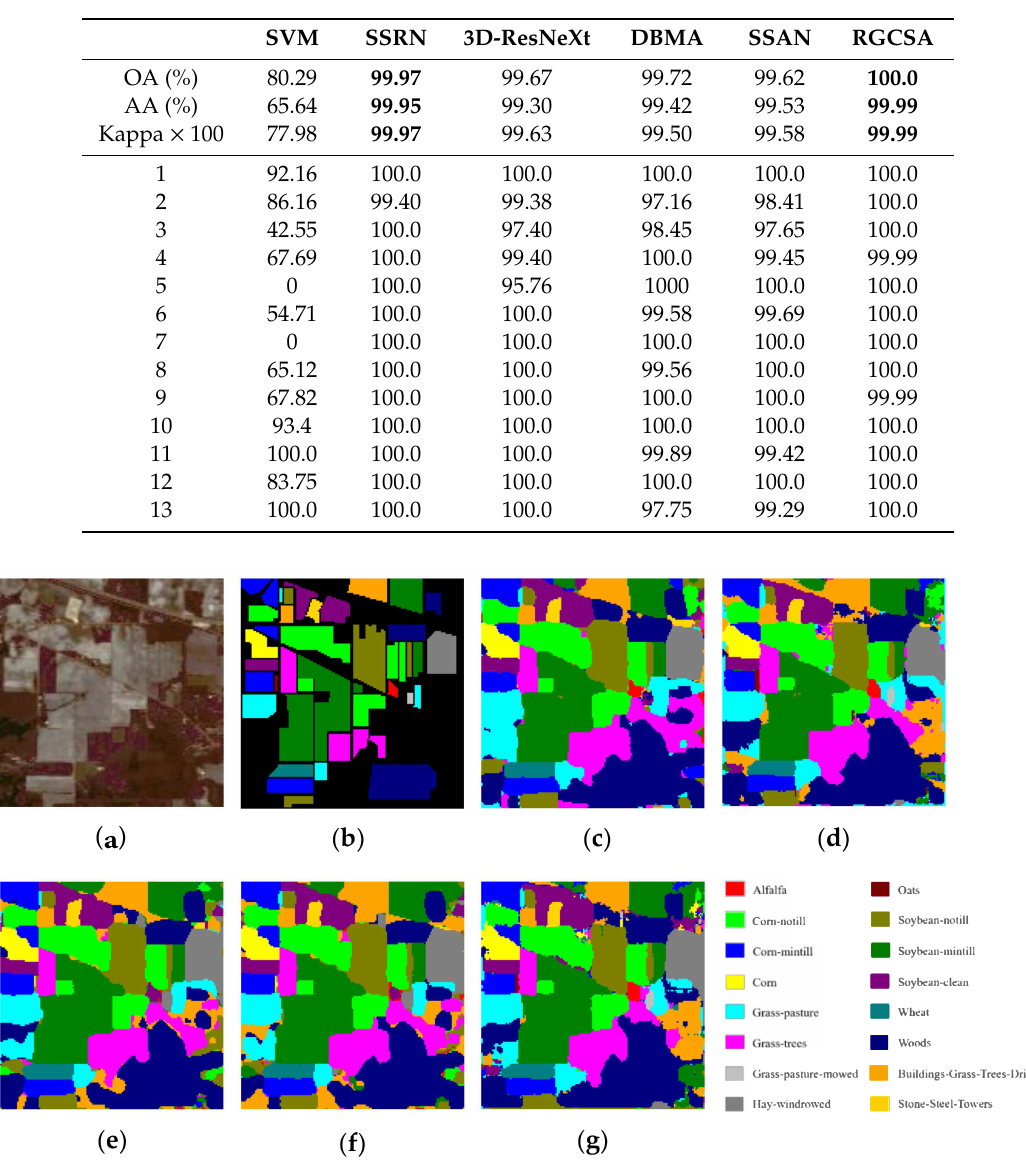
Figure 10. Classification results of the models in comparison with the IN dataset. ( a ) False color image. ( b ) Ground-truth labels, ( c – g ) Classification results of SSRN, 3-D-ResNeXt, DBMA, SSAN, and